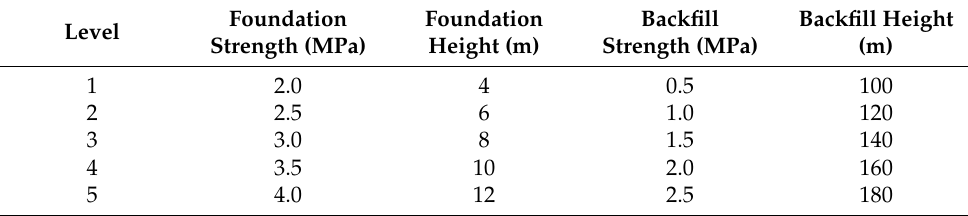
Table 2. Backfill parameter